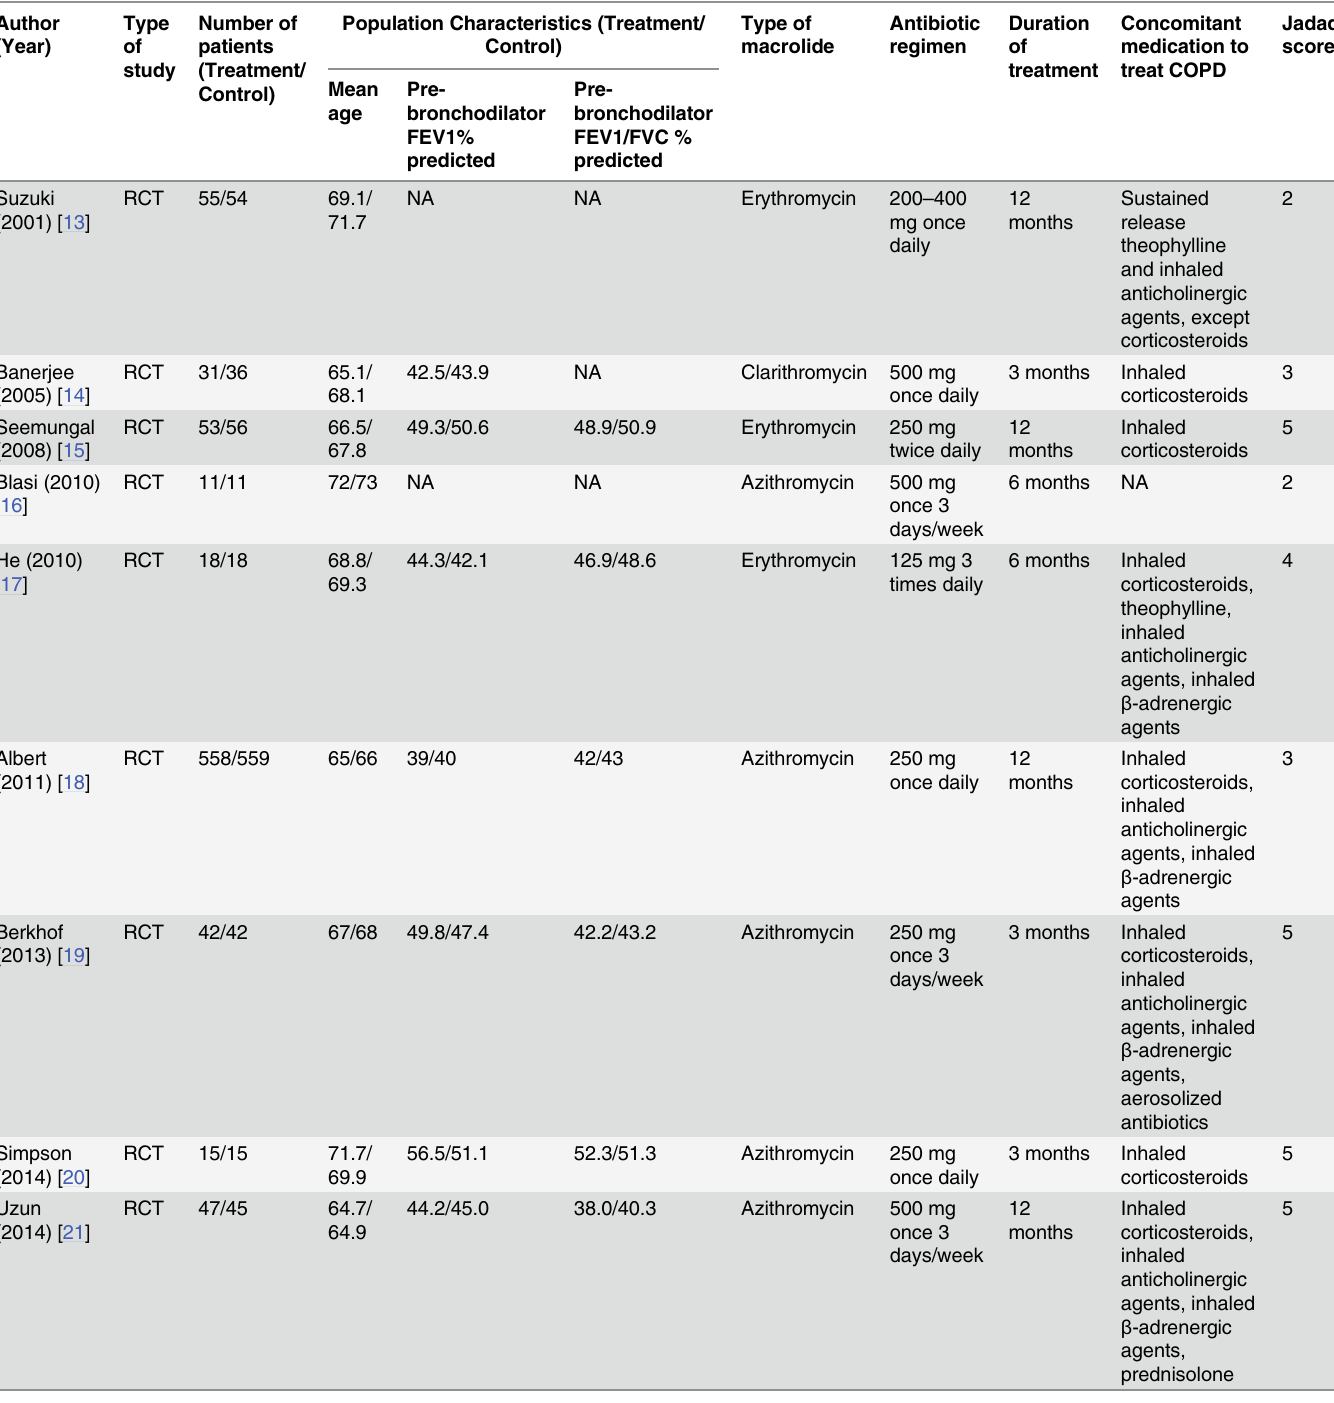
Table 1. Characteristics of studies included in the